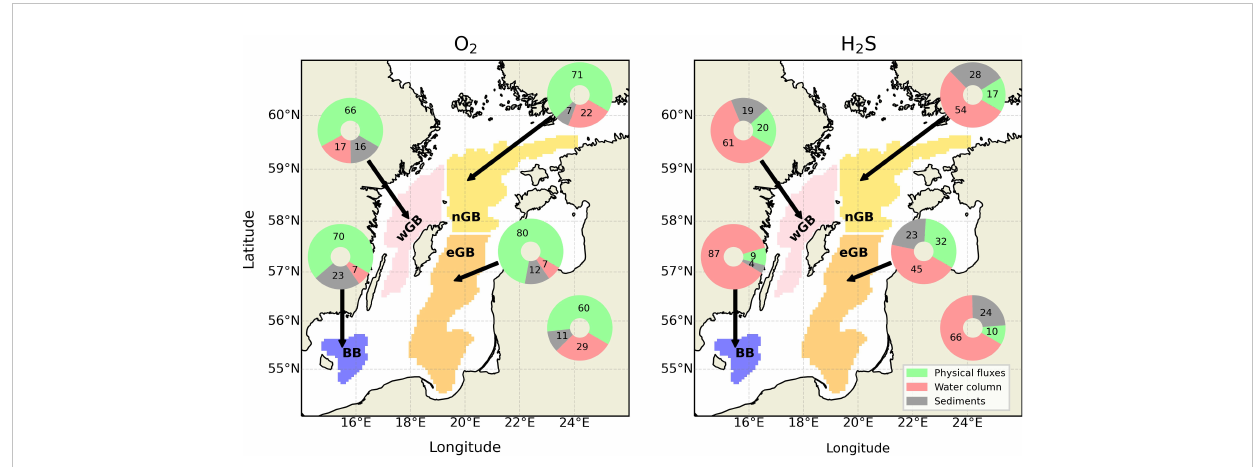
FIGURE 4 Fraction of interannual O 2 (left panel) and H 2 S (right panel) variability (in %) explained by the certain group of processes, namely physical fl uxes, which includes advection, diffusion, and other physical processes, water column, which includes all processes from O 2 or H 2 S budgets situated in the water column, and sediments, which includes all processes situated in the sediments. The numbers are presented inside the pie-charts. Different sub-basins are marked by areas with different colors. The lower right pie-charts represents the whole central Baltic Sea. See Supplementary Tables 1 and 2 for more information about processes in each